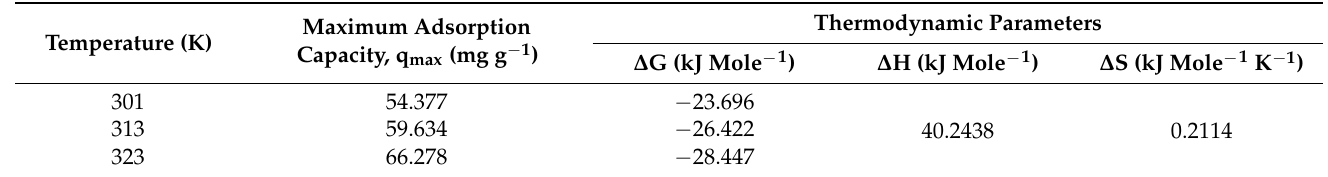
Figure 14. Effect of temperature on equilibrium RBBR dye uptake onto WSBAC adsorbent. (Initial pH: 2; initial dye concentration: 25–225 mg L − 1 ; WSBAC adsorbent dosage: 6 g L − 1 ; adsorbent particle size: 55.21 µ m; agitation speed: 150 rpm; contact time: 24 h). Table 10. Thermodynamic parameters for the adsorption of RBBR dye onto WSBAC